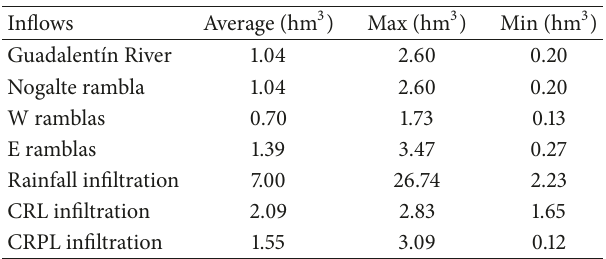
Table 1: Yearly water